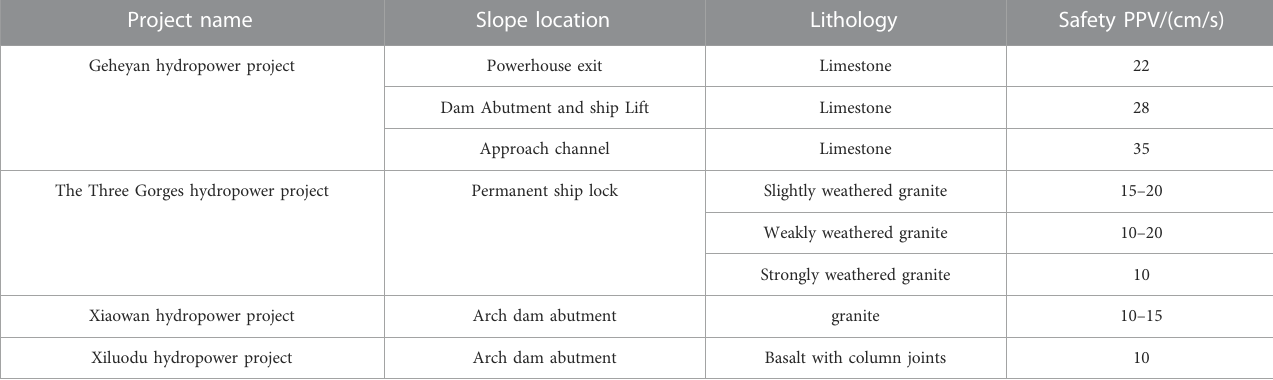
TABLE 2 Safety standard of blasting vibration for slopes of several hydropower projects in China.